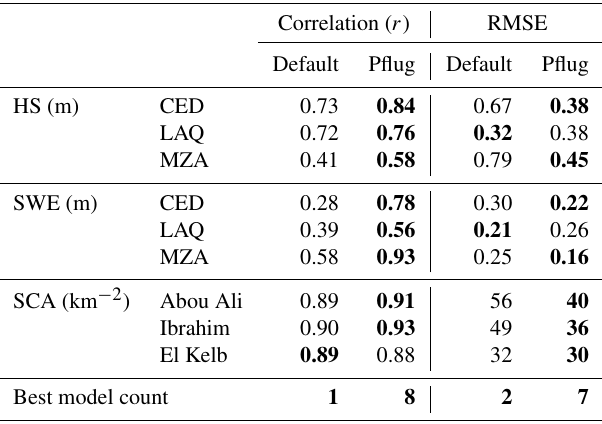
Table 3. Performance of both model runs, default SnowModel and Pflug et al. (2019). HS is daily snow height from continuous acous- tic gauges, SWE is snow water equivalent from snow course mea- surements, and SCA is daily snow cover area from MODIS. The values in bold indicate the best